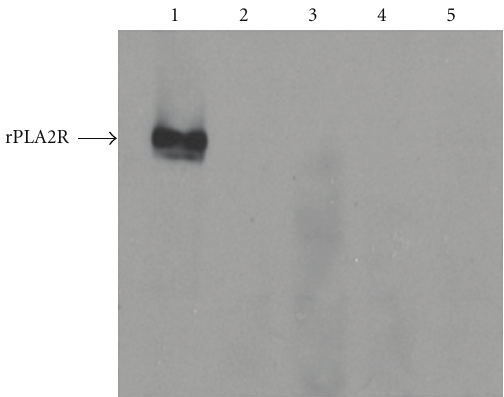
Figure 1: Representative immunoblot demonstrating that sera from patients with IgG4-RD (lanes 2–5) lack detectable reactivity with rPLA2R. Serum from a patient with idiopathic membranous nephropathy (lane 1) was used as a positive